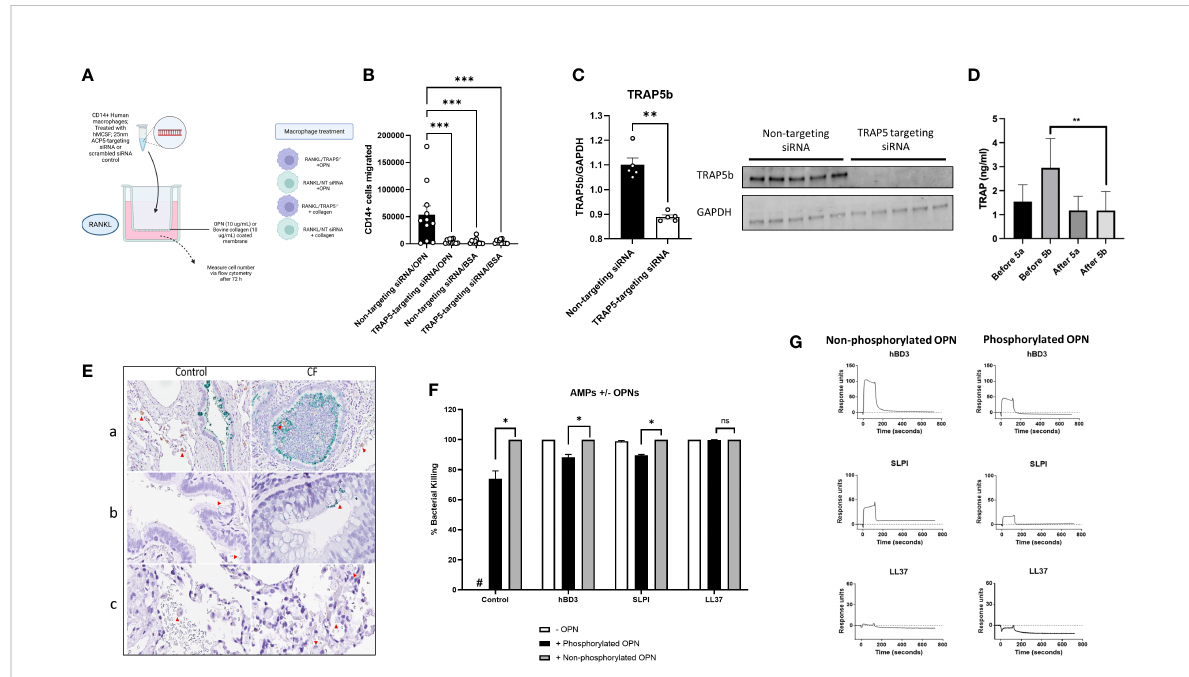
FIGURE 1 Immune cell recruitment and TRAP5 expression in patient samples. (A) Human leukocytes were treated with rhM-CSF for 5 days. Cells were then transfected with TRAP5-targeting siRNA or scrambled siRNA control. (B) Cells were added to a transwell assay and CD14+ cells were measured in the basal well after 72h of RANKL stimulation. Statistical analysis was conducted using one-way ANOVA with a Dunnet ’ s post hoc test (***P<0.001). (C) Immunoblotting for TRAP5b from human macrophage cell lysates. (D) TRAP5a and 5b levels in human BALF collected from patients exposed to swine dust. TRAP isoform levels were determined via enzyme-linked immunosorbent assay (ELISA). Results represent the mean and standard deviation of all the samples run. Statistical analysis was performed using Student ’ s t-test ( ** P< 0.01). (E) Immunohistochemical detection of TRAP5a/OPN in human lung tissue using a proximity-ligation assay (Navinci), with interactions between the two molecules shown in green. Images show (a) OPN and TRAP5a in small airways, (b) in alveolar macrophages and (c) capillaries. The red arrows show the TRAP5a positive cells. Image (a): 40x magni fi cation. Images (b, c): 60x magni fi cation. (F) Pseudomonas aeruginosa killing assay showing bacterial killing following hBD3, SLPI, and LL37 (0.1 m M) following incubation with either dOPN or pOPN. Statistical analysis was conducted using one-way ANOVA with a Dunnet ’ s post hoc test ( *P < 0.05). (G) SPR sensorgrams illustrating interactions between hBD3, SLPI, LL37, and dOPN/pOPN. NS-not signi fi